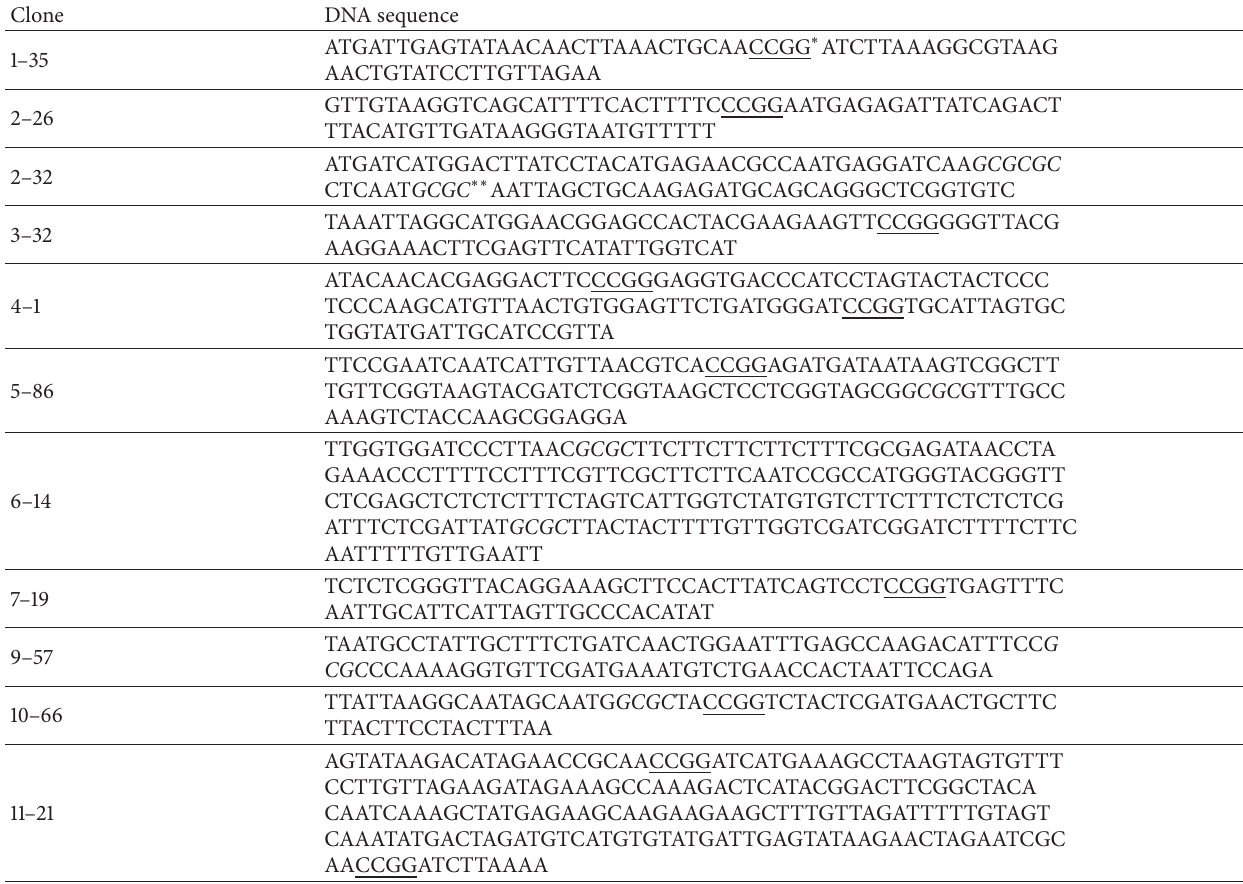
Table 2: DNA sequences of some fragments from the differential-methylation subtractive library. Clone DNA